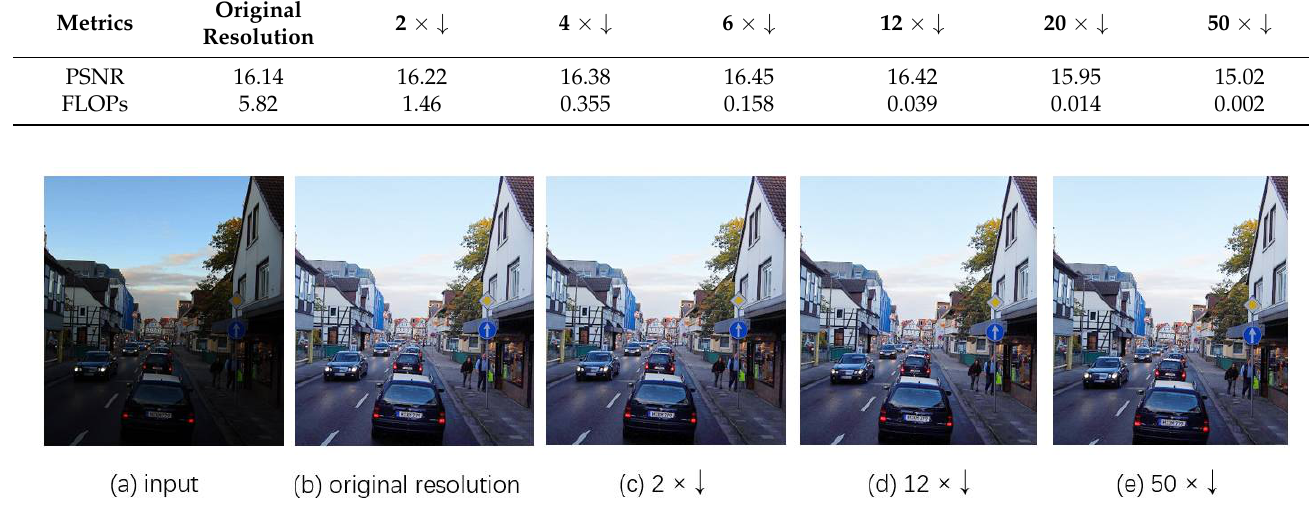
Figure 7. Ablation study of input image size. Subfigure ( a ) shows the original input, subfigure ( b ) shows the enhanced image result when the image resolution is not changed, subfigure ( c – e ) show the image enhancement results after downsampling the input image.